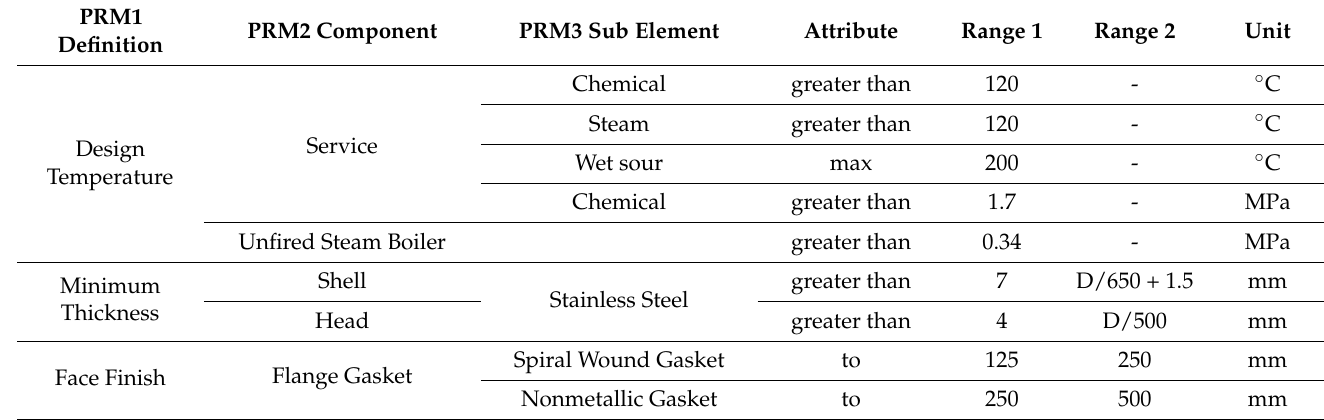
Table 3. SDP of pressure vessels in mechanical process discipline (excerption).